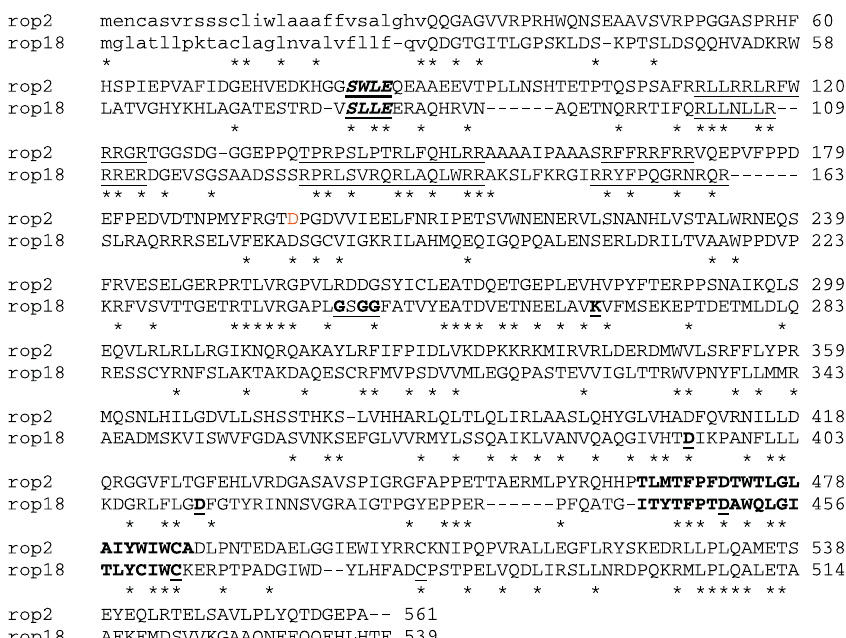
Figure 1. Alignment of the ROP2 and ROP18 Sequences The identities are underlined by asterisks. The predicted signal sequences are in lower case. The three arginine-rich regions in the Nt of the proteins are underlined. The S U XE motif, putative maturation site of the pro-region, is in bold italics and underlined; the kinase activity key amino acids are in boldface and underlined (G stretch, catalytic lysine, and key aspartates); the hydrophobic stretch predicted as transmembrane is in bold letters; and the two conserved cysteins in the C-terminal domain are